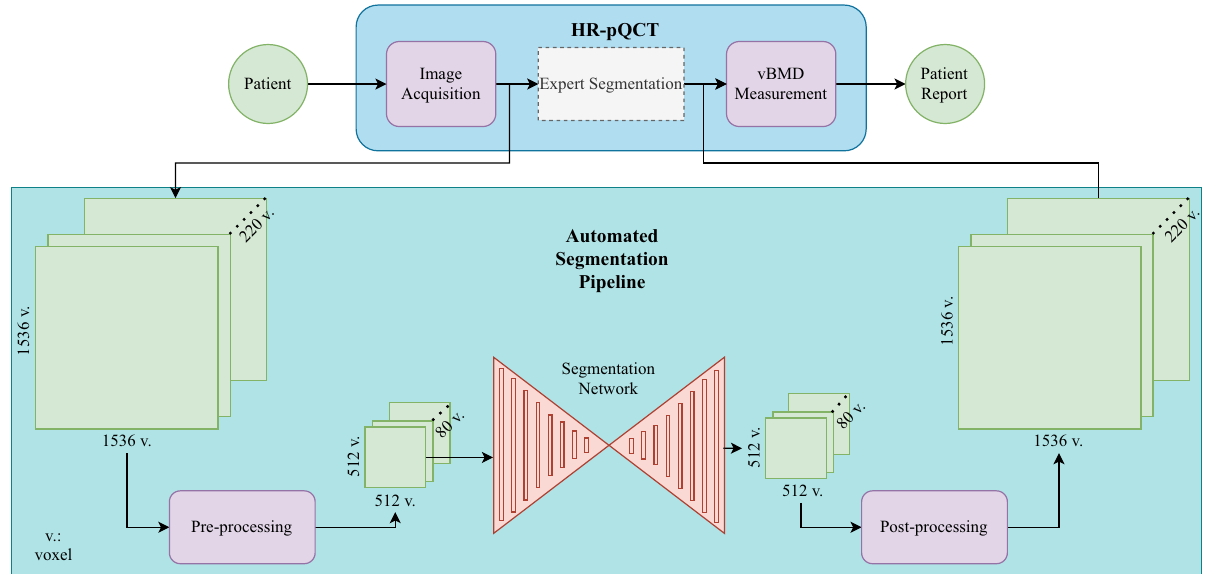
Figure 1. The pipeline to generate a patient report can be subdivided into the following steps: (1) image acquisition using the HR-pQCT scanner, (2) segmentation of the second MC in the volumes, (3) calculation of the vBMD using the segmentation masks. As the manual and the automatic pipeline only differ in the segmentation step, the automatic segmentation pipeline can be considered a drop-in replacement of the semi- automatic, time-intensive expert